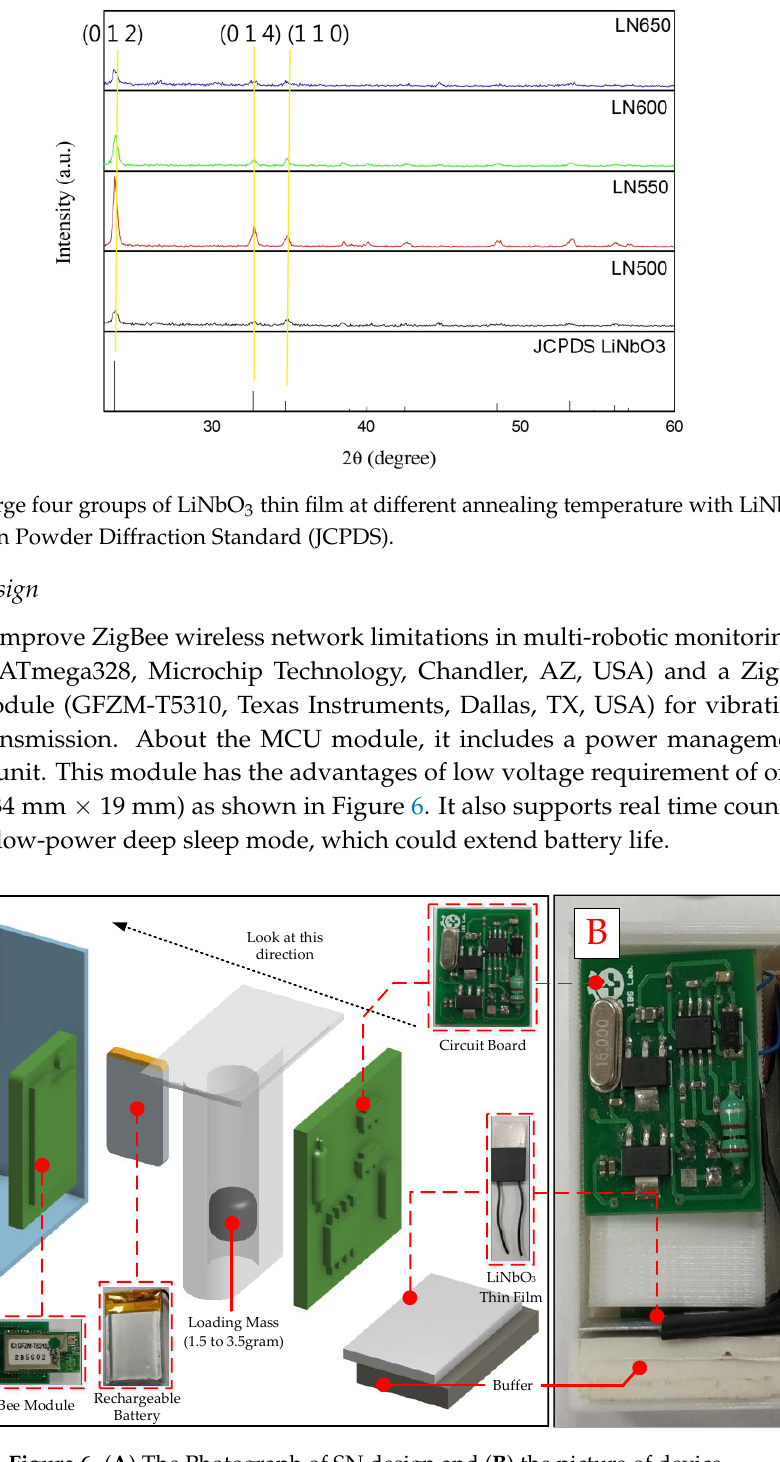
Figure 6. ( A ) The Photograph of SN design and ( B ) the picture of device.